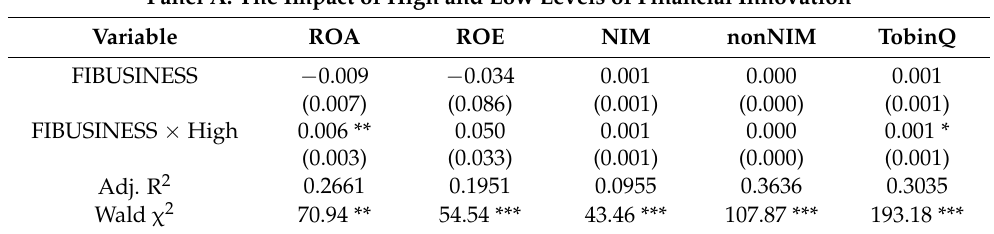
Table 7. The results of robustness analysis. Panel A: The Impact of High and Low Levels of Financial